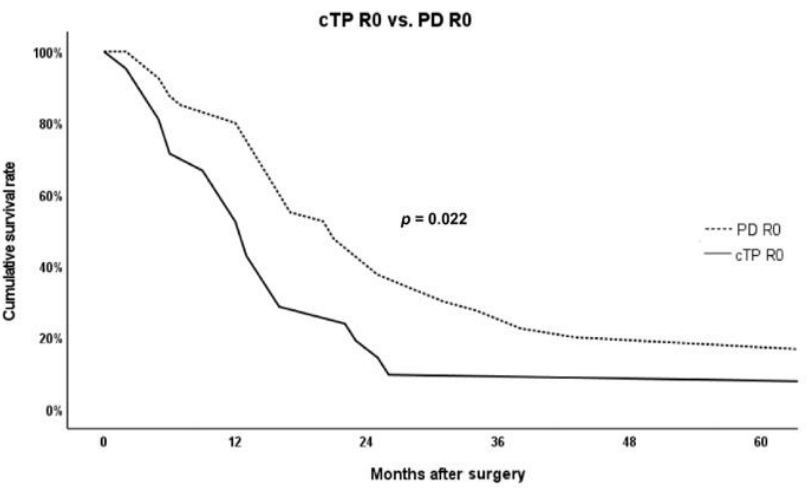
Figure 3. Comparison of overall survival between cTP R0 group and PD R0 group extracted by PSM. Abbreviations: cTP, completion total pancreatectomy; PD, pancreaticoduodenectomy; PSM, propensity score matching.